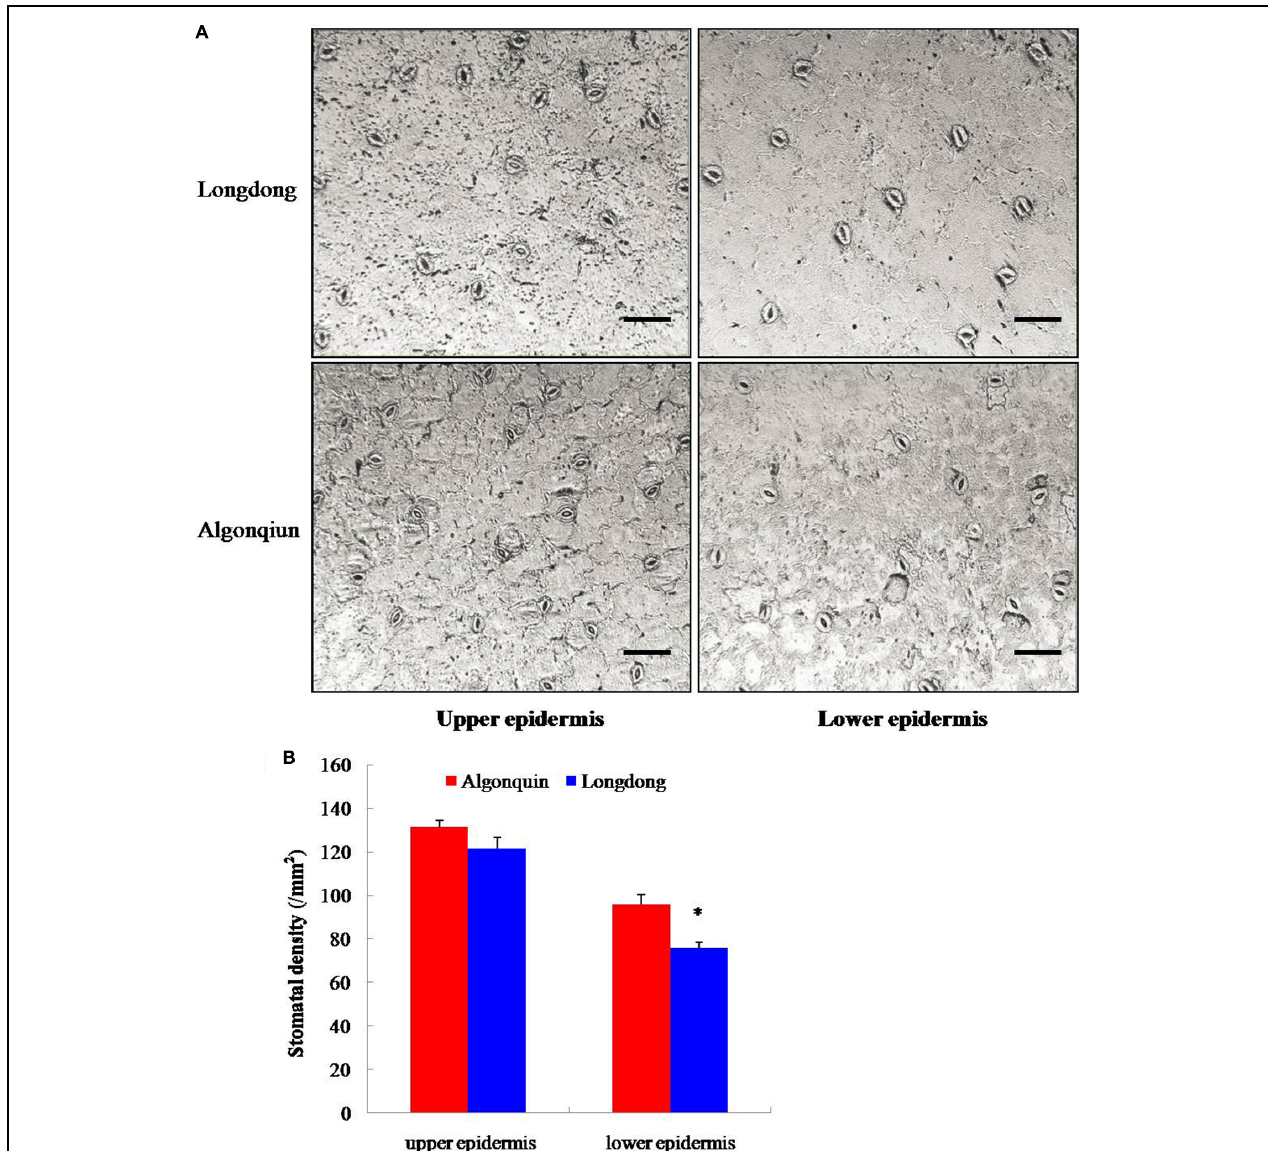
FIGURE 2 | Evaluation of stomatal density. (A) The upper epidermis and lower epidermis of 4-week-old terminal leaflets were photographed by fluorescence microscope. Bars = 50 µ m. (B) Stomatal density of well-watered Longdong and Algonquin ( n = 15). The results shown are means ± SE. Asterisk symbols indicate significant differences at P < 0.05 (Student’s t